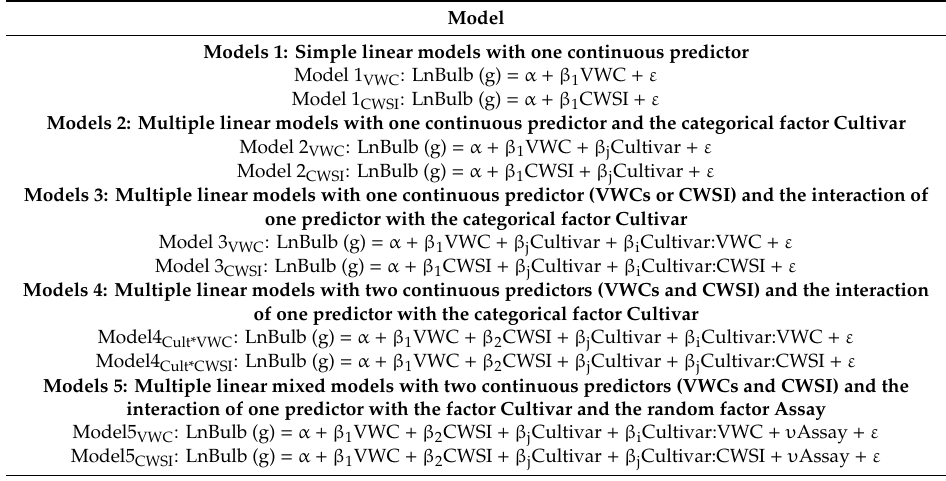
Table 3. Description and variables included in each of the tested